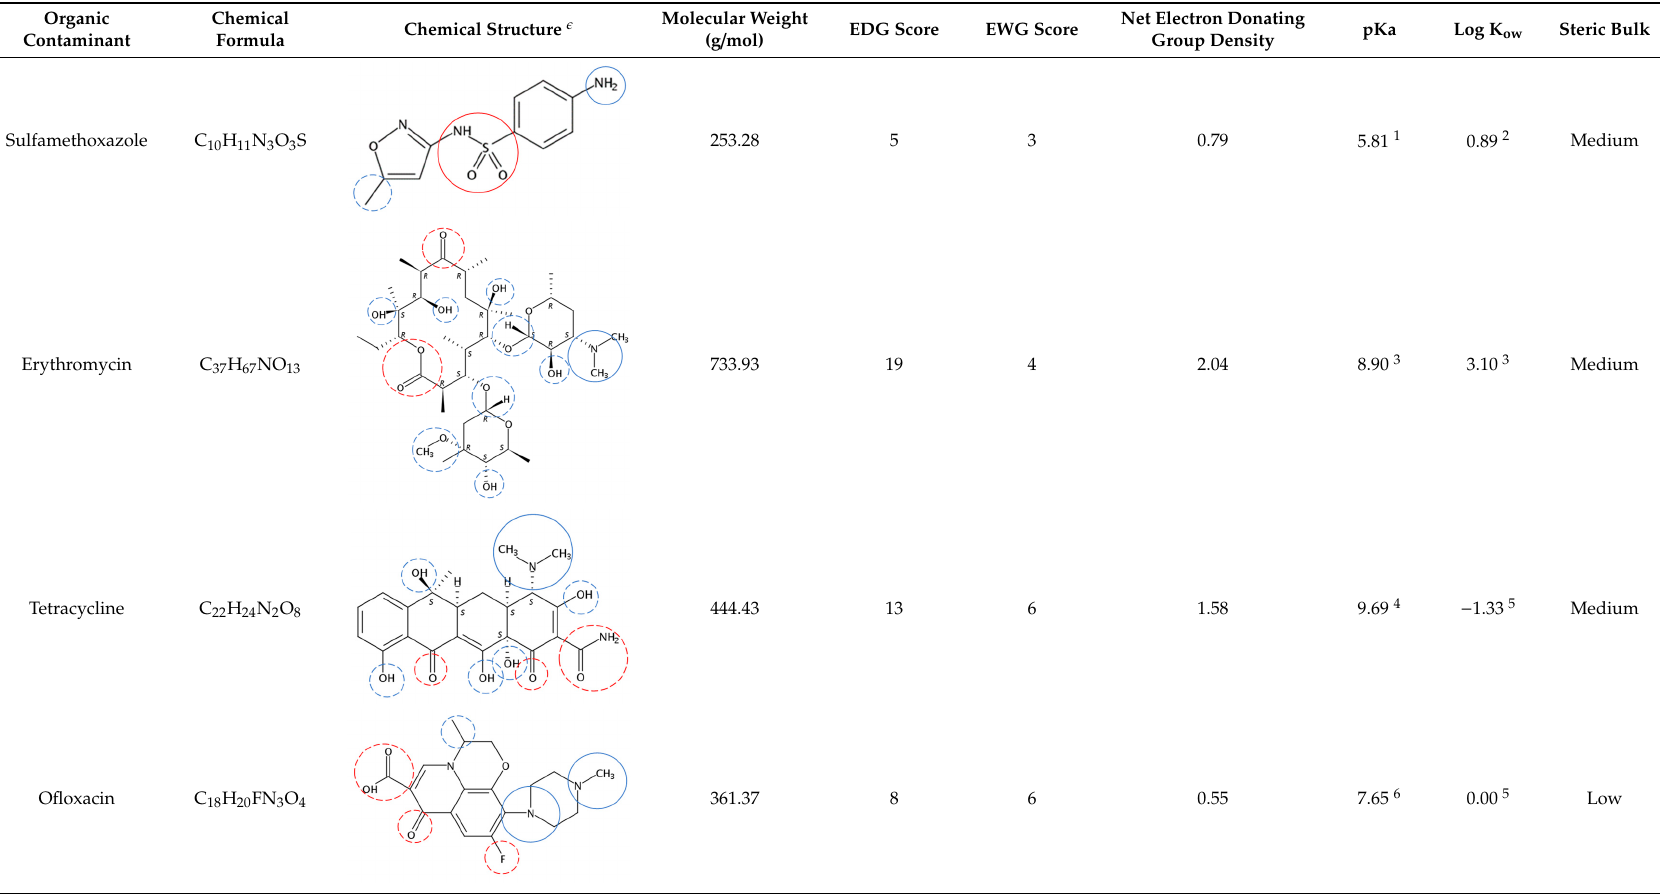
Table A1. Representative OCs shortlisted for susceptibility assessment and their respective assessment criteria data.